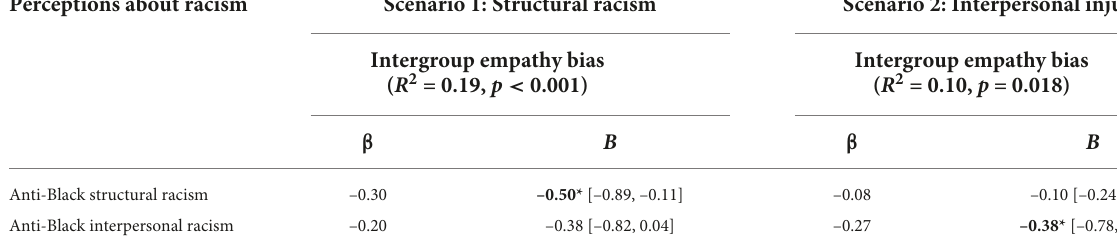
TABLE 4 Simultaneous regressions predicting intergroup empathy bias as a function of perceptions of anti-Black structural and anti-Black interpersonal racism: Study 3. Perceptions about racism Scenario 1: Structural racism Scenario 2: Interpersonal injustice Intergroup empathy bias ( R 2 = 0.19, p < 0.001)